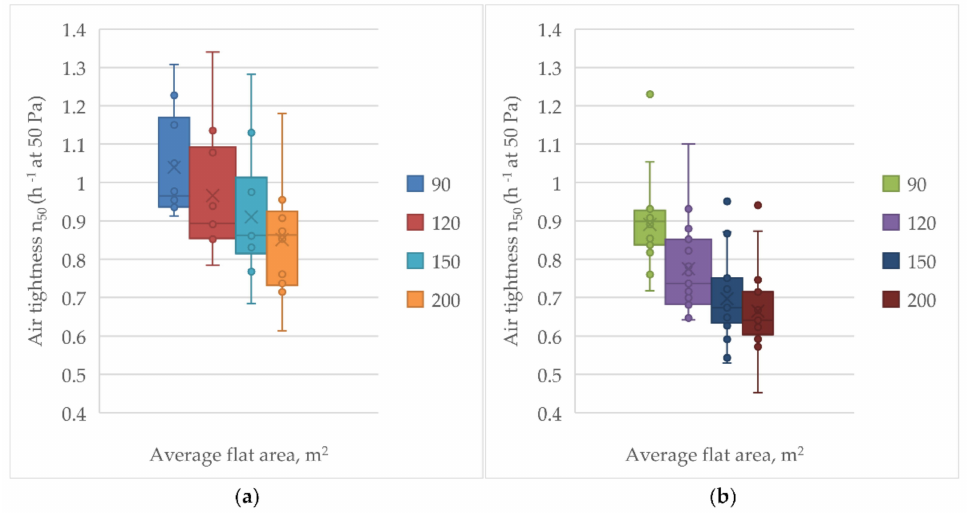
Figure 6. Airtightness of buildings: ( a )—end units (flats), ( b )—inside units